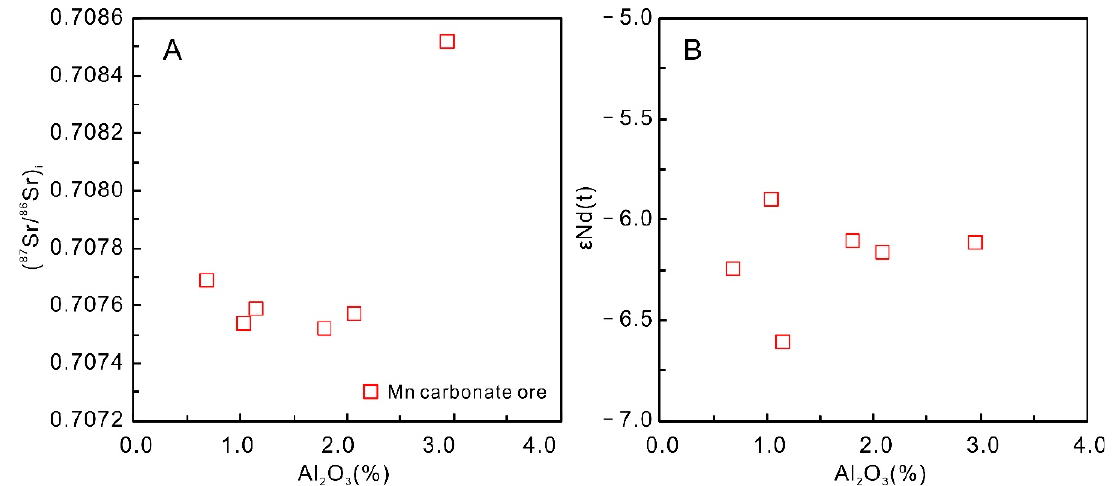
Figure 5. Cross-plots of ( A ) ( 87 Sr/ 86 Sr) i and ( B ) ε Nd(t) vs. Al 2 O 3 content for the Ortokarnash Mn(II) carbonate